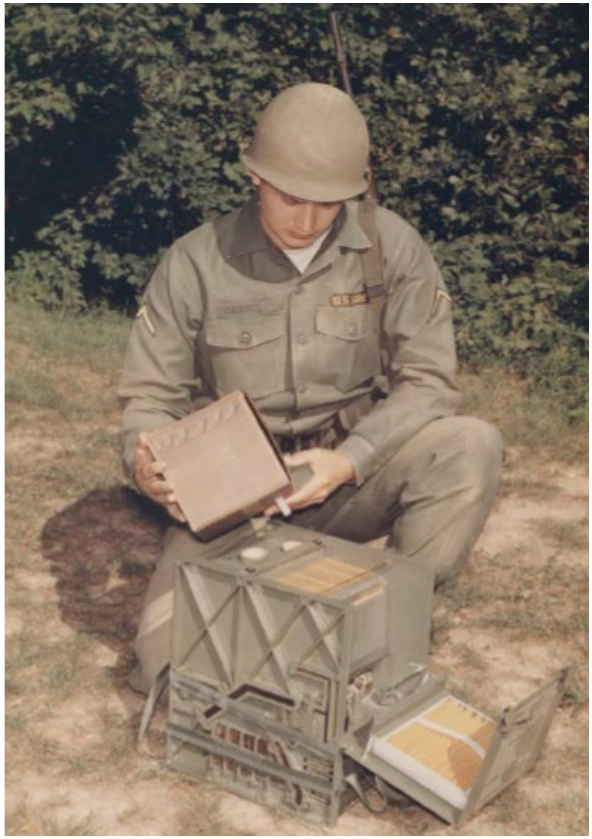
Figure 8. A soldier refuels a 300 W hydrazine fuel cell, ca. 1964. Courtesy of the US Army Mobility Equipment R&D Center.